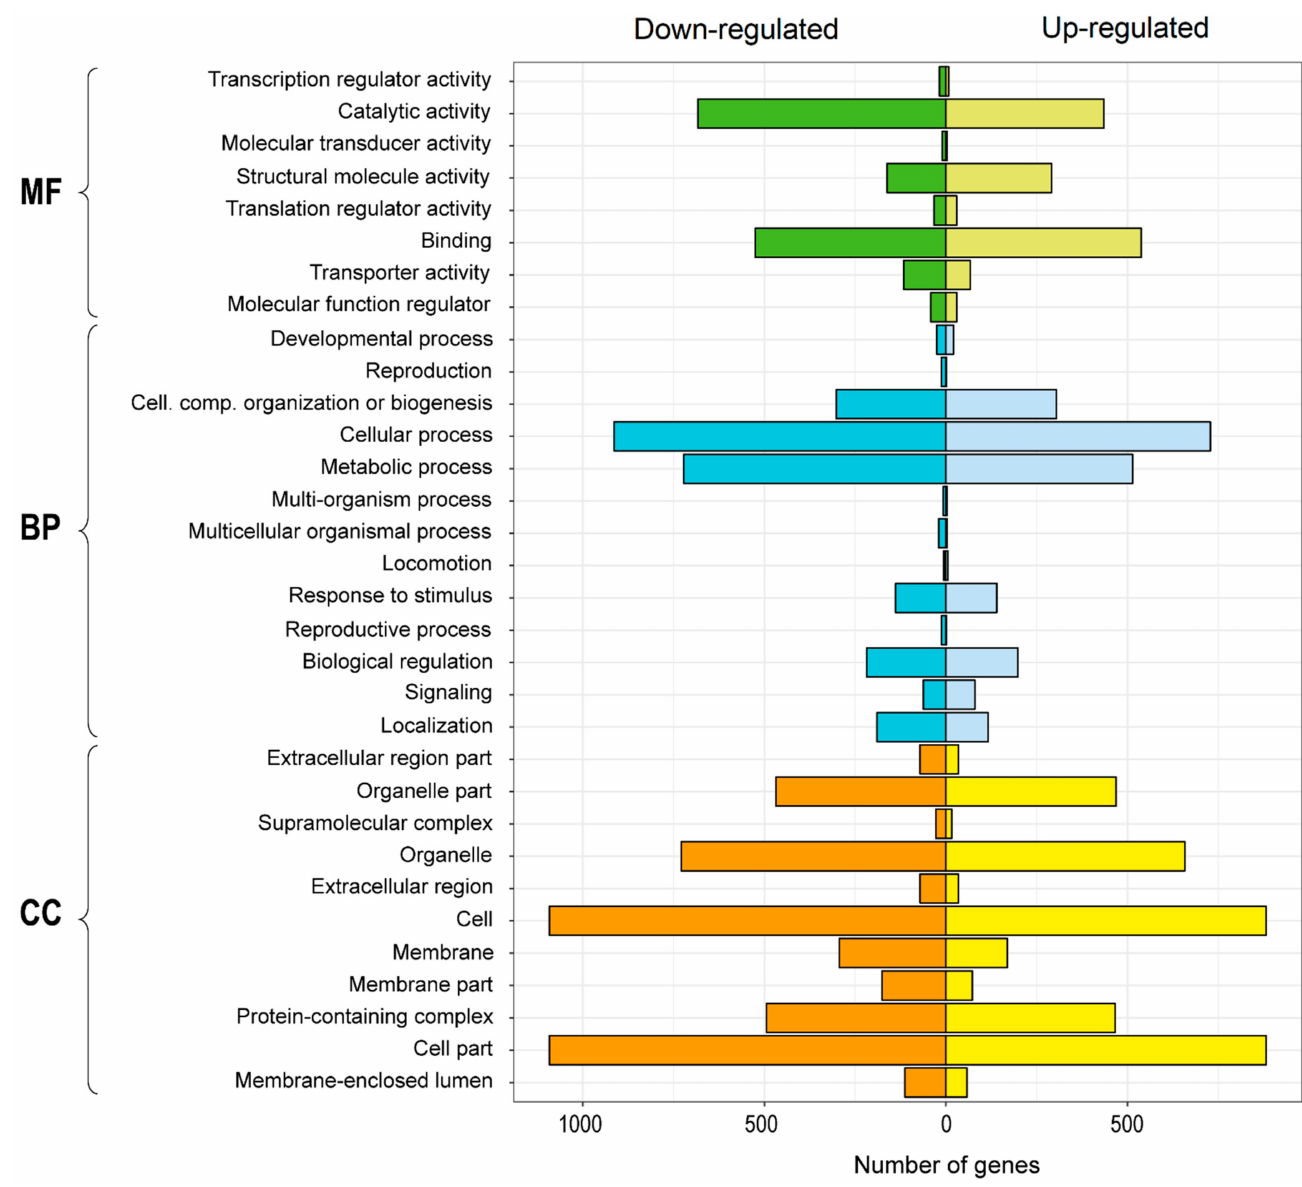
Figure 4. Gene ontology distribution in de novo transcriptome of Imperata cylindrica according to level 1 categories: Cellular Component (CC), Biological Process (BP), and Molecular Function (MF). Genes are differentially expressed in treatment compared to control